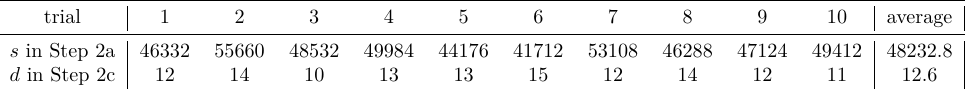
Table 3: Experimental results for the attack on Yoroi